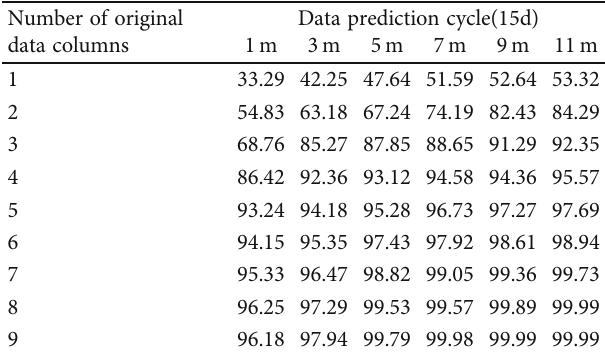
Table 3: The prediction accuracy of 15 days before the push data under the comprehensive